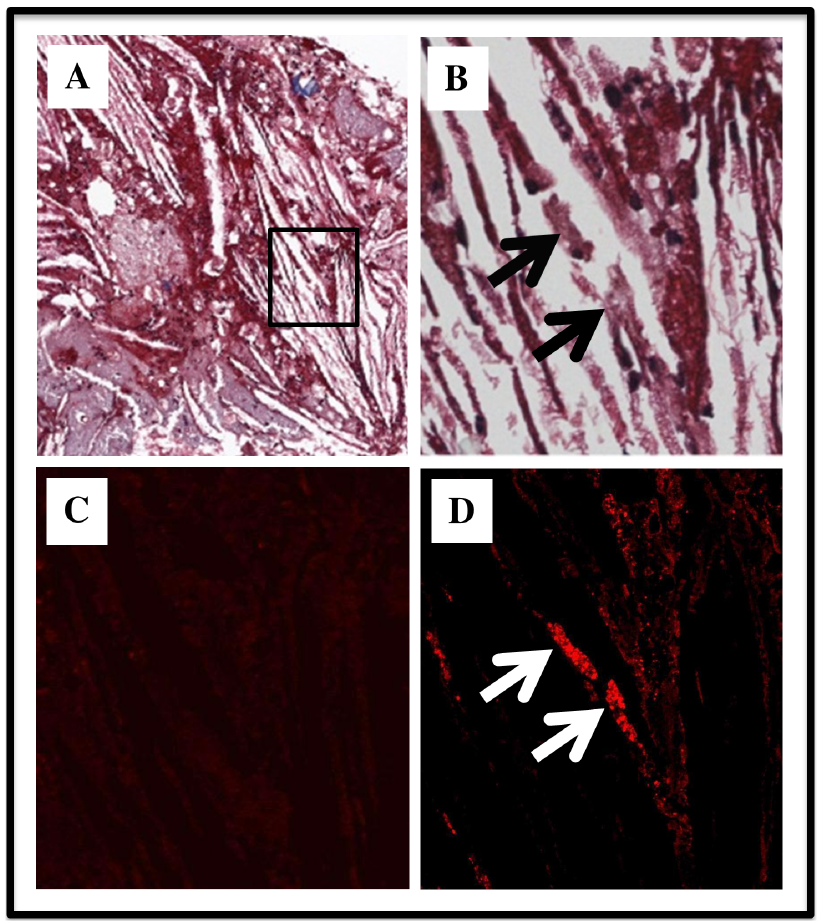
Figure 4. Light and Confocal Microscopy of MAA in the Culprit AMI Aspirated Tissue. Panel A and B illustrates a Masson’s Trichrome staining at low (20X) and high magnification (80X) with panel B as the inset box of panel A. Panel C is the rabbit IgG isotype control stain. Panel D illustrates the rabbit anti-MAA staining with Cy3 reporter (80X). Note the absence of collagen or fibrosis and the presence of cholesterol clefts in Panel A which are typical of an atheroma. Also note the localization of MAA in Panel D (white arrows) to cellular vacuolization and necrosis as noted by the arrows on the Masson’s Trichrome in Panel B (black arrows).